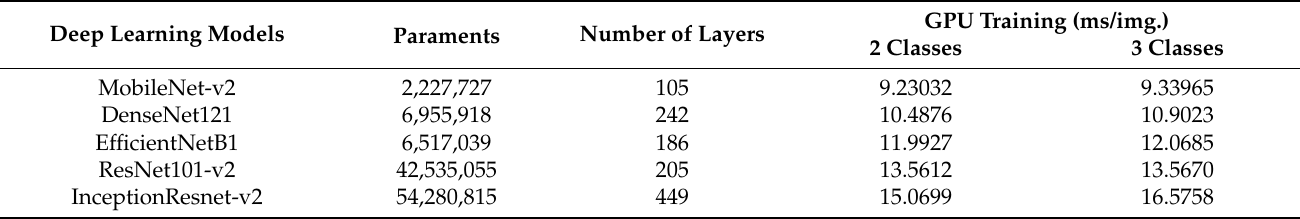
Table 3. Configurations of convolutional deep learning models.